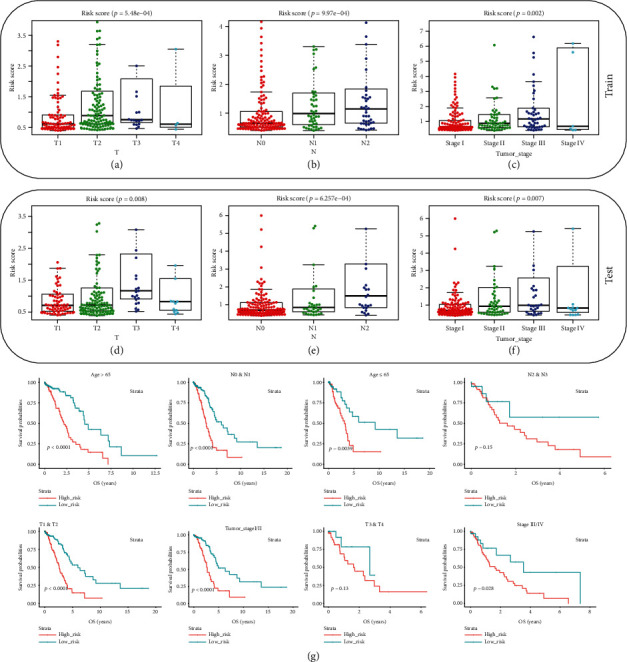
Prognostic impact of the model in clinical characteristics. The correlation of the 7-gene signature-based risk score with the TNM stage was analyzed in the (a–c) training set and (d–f) testing set. (g) OS curves were plotted for validation of the predictive ability of the 7-gene signature-based risk score in patients with different age and TNM stage.